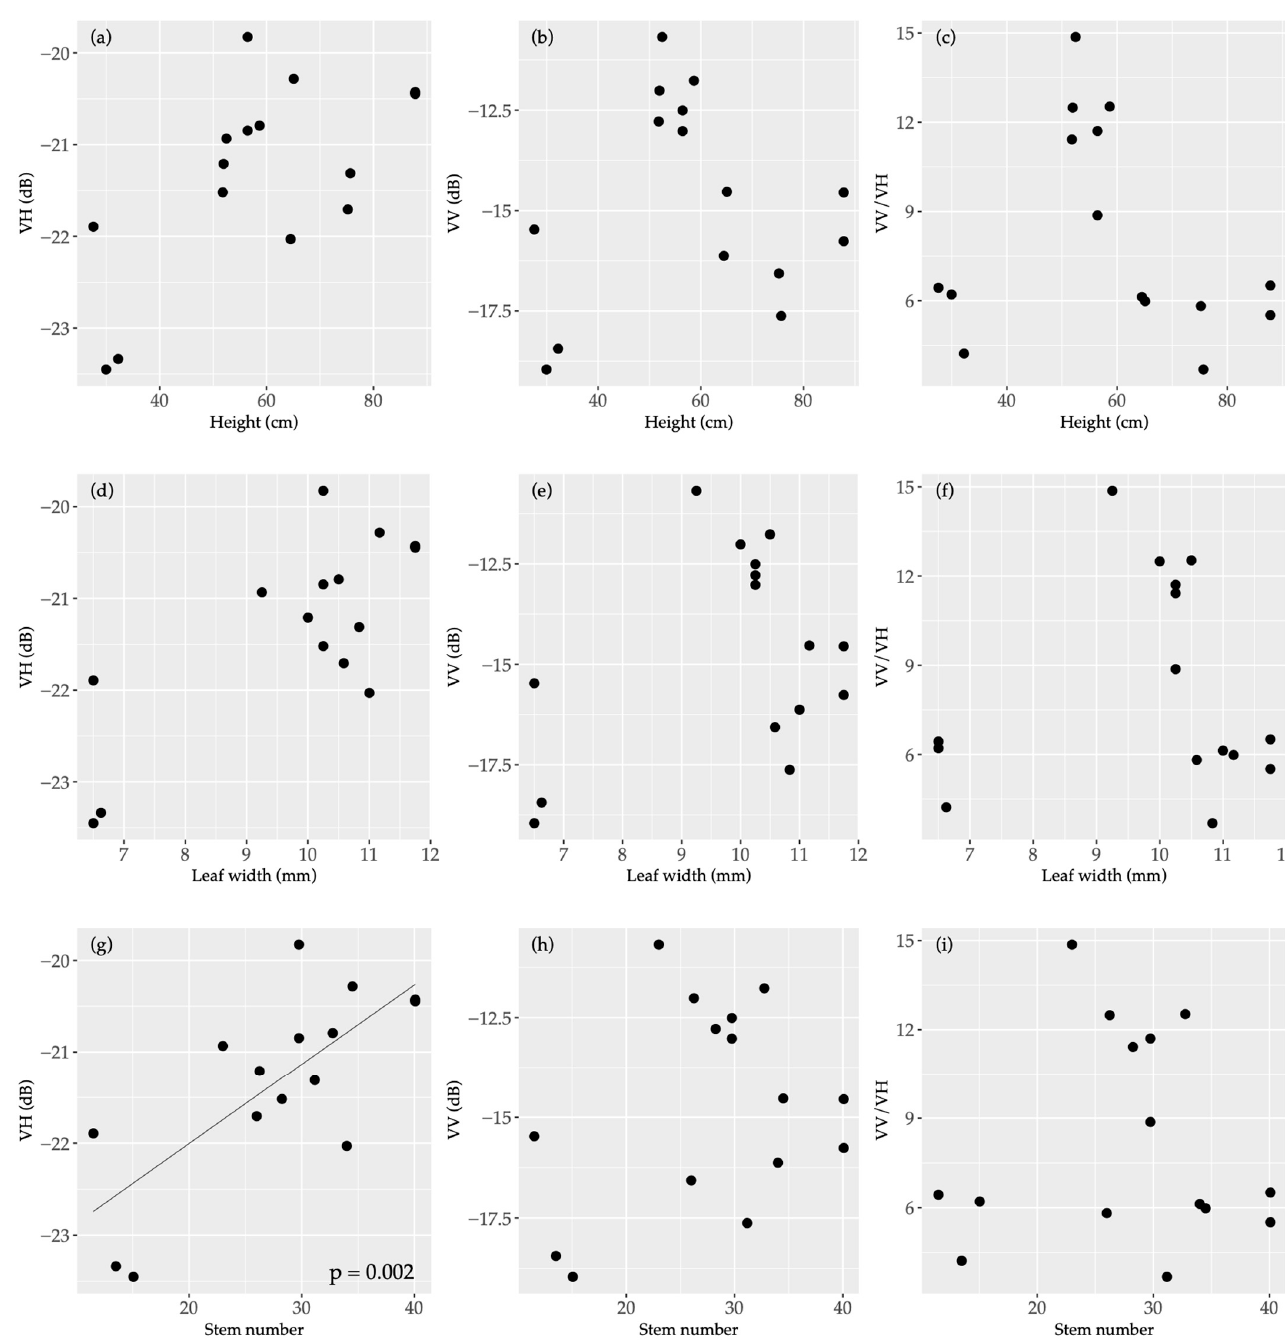
Figure 7. Scatterplots of field-observed biophysical parameters in the vegetative stage and microwave backscatter values from orb 46. Plant height (cm), maximum leaf width (mm), and stem number were measured in the tillering stage. The leftmost column depicts VH, the center shows VV, and the rightmost presents VV/VH. ( a – c ) plant height, ( d – f ) maximum leaf width, and ( g – i ) stem number, respectively.